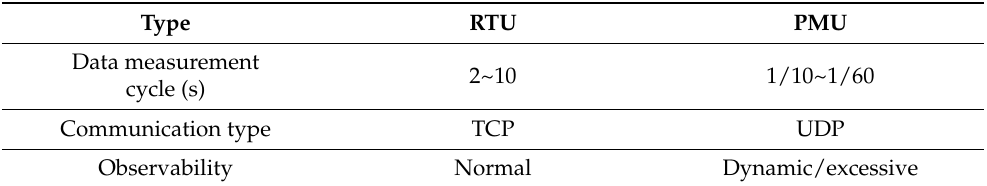
Table 2. Difference between RTU-based and PMU-based